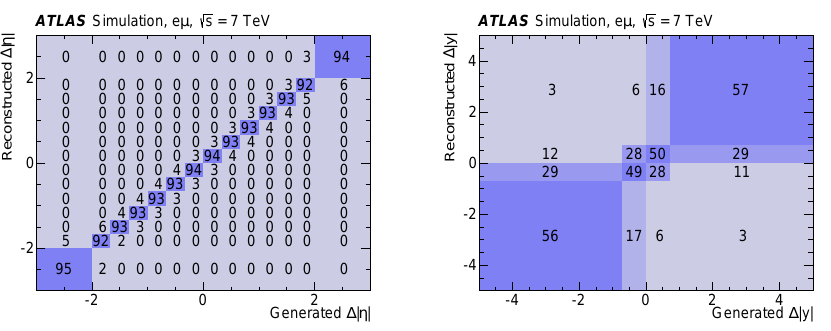
Figure 1. Response matrices for the lepton ∆ | η | observable ( left ) and the t ¯ t ∆ | y | observable ( right ) in the e µ channel. Each column of the matrices is normalized to unity and values are reported as percentage [20].